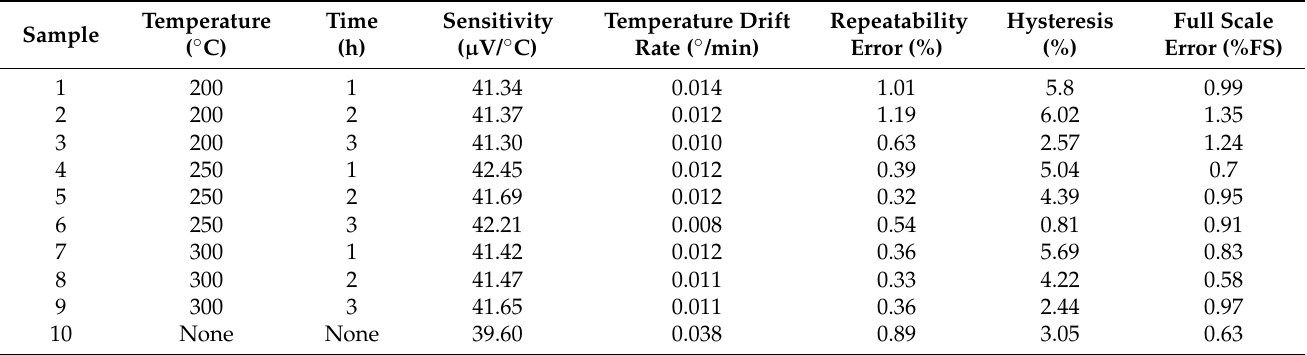
Table 3. Characteristic parameters of the sensor with different heat treatment parameters.